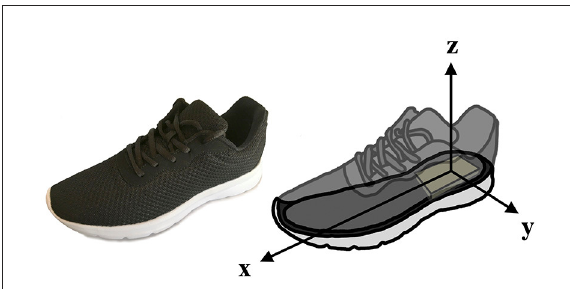
FIGURE1 Schematic illustration of WGAS ecosystem embedding sensors in the outsole of the